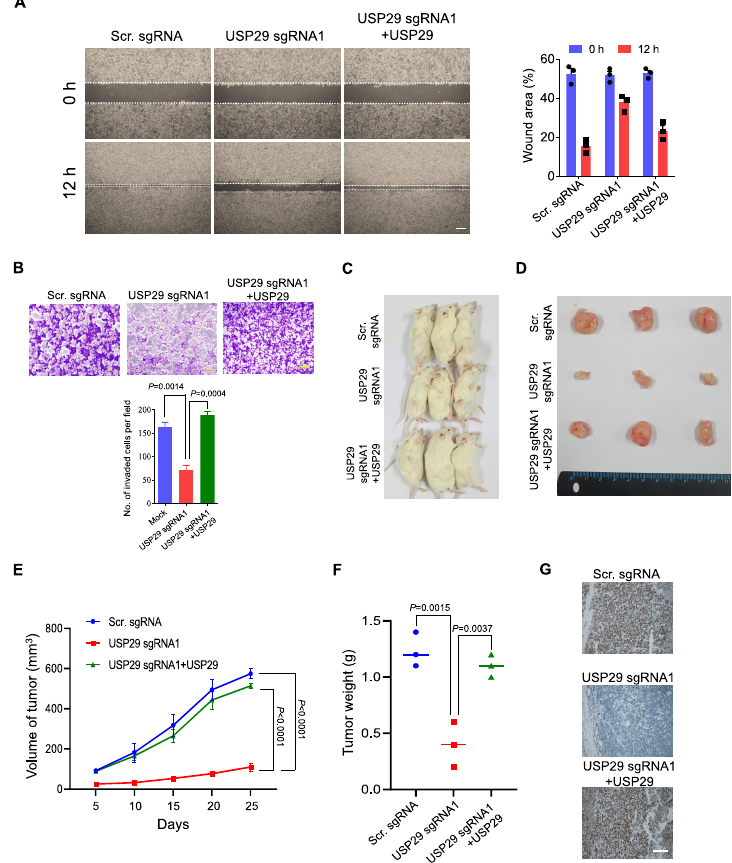
Figure 5. USP29 depletion reduces the pathogenesis of colon cancer in vitro and in vivo. ( A ) HCT116 cells were transfected with the indicated plasmids and wound healing assay was performed to assess for their migratory potential. Representative images were captured at 0 and 12 h (Scale bar = 500 µ m) and the percentage of wounded area is indicated in the right panel. ( B ) Matrigel cell invasion assay was performed in HCT116 cells. Cells were transfected with the indicated plasmids and cells were seeded into the upper chamber of the Transwell plate. AT 24 h, cells on the lower side of the chamber membrane were fixed and stained with crystal violet, and cell invasion was quantified graphical representation. Scale bar = 200 µ m. ( C – F ) HCT116 scrambled sgRNA control, USP29-depleted, and USP29-depleted HCT116 cells with reconstituted USP29 were subcutaneously injected into NSG mice for xenograft experiments. The tumor volume was estimated every other day for 4 weeks and is graphically represented. Then, the tumors were harvested to acquire representative images. The tumor weights were measured and are graphically represented. ( G ) Tumors from the in vivo study was sectioned and embedded in paraffin. IHC was performed using USP29-specific antibody. Scale = 50 µ m. Data in ( A , B , E , F ) are presented as the mean ± standard deviation of three independent trials. p -values were calculated using Two-way